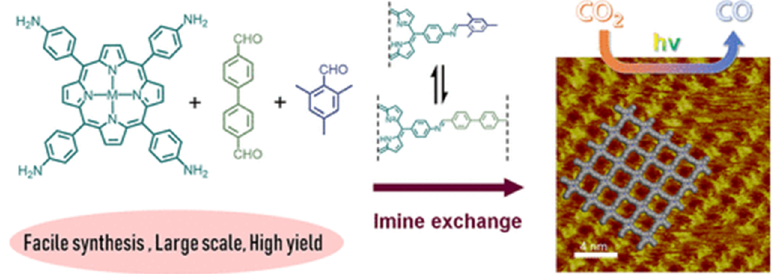
Figure 2. Schematic illustration of synthesis of the COF-367 NSs for CO 2 photoreduction to CO and its STM image. Copied with permission from ACS 2020 [31]. STM image. Copied with permission from ACS 2020